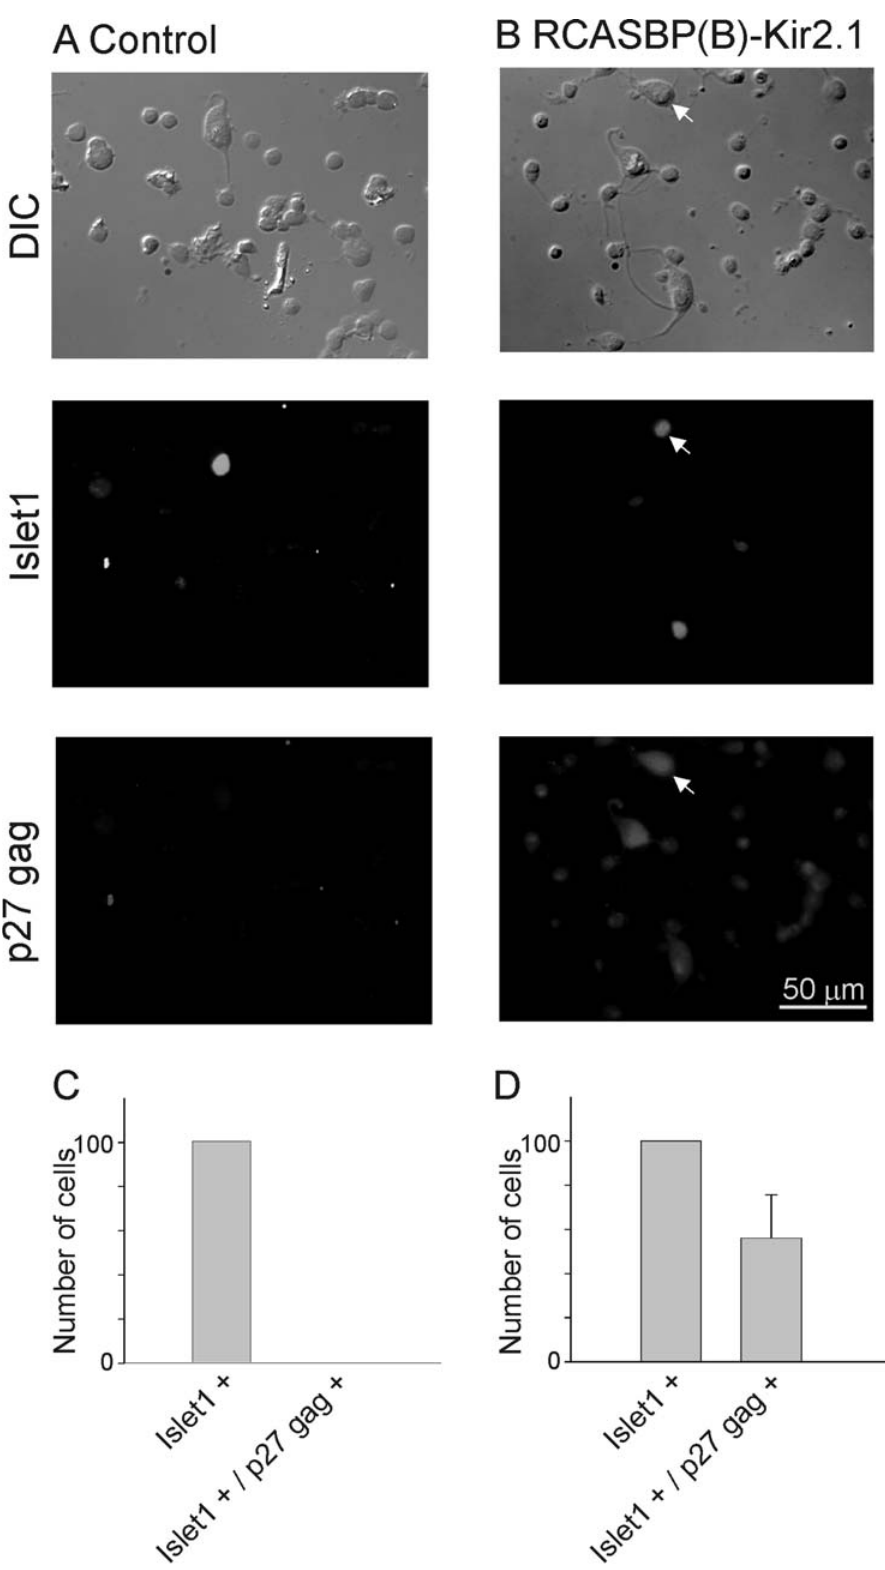
Figure 3. Immunolabeling of isolated ventral spinal cord neurons for p27 gag and Islet1/2. Ventral spinal cords from control (non- infected, A ) and RCASBP(B)-Kir2.1 infected embryos ( B ) were isolated at E8. Dissociated neurons were plated on poly-D-lysine coated coverslips and inmunolabeled with the motoneuron marker Islet 1/2 and the viral protein p27 gag. The arrow in B represents a typical motoneuron showing Islet 1/2 and p27 gag labeling. C&D) Averaged number of double labeled neurons for Islet 1/2 and p27 gag (as a percent of the total number of Islet -positive neurons) in control and RCASBP(B)-Kir2.1 infected embryos (n=3). doi:10.1371/journal.pone.0002971.g003 PLoS ONE |